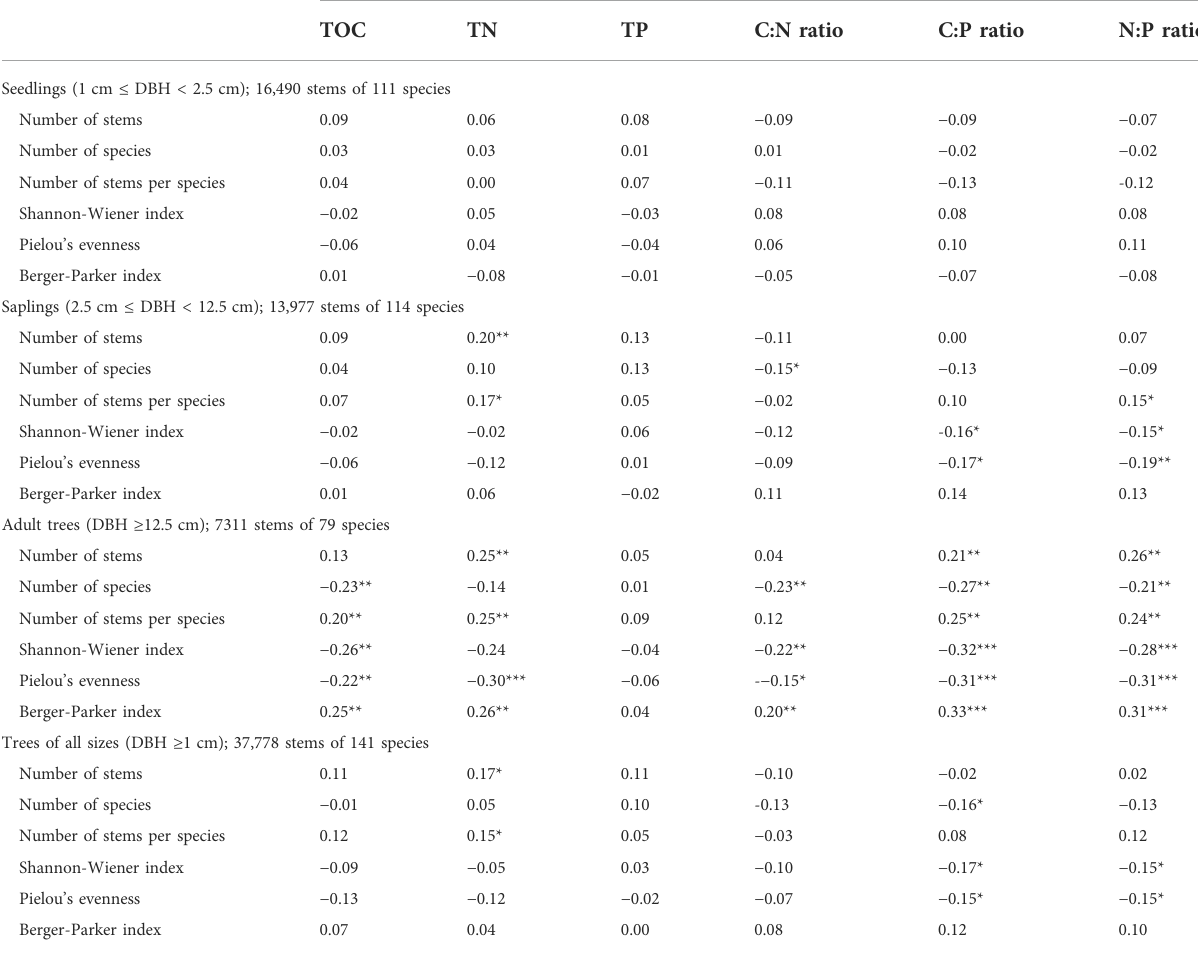
TABLE 2 Pearson correlation coef fi cients of six vegetation-related biotic factors with soil total organic carbon (TOC, g kg − 1 ), total nitrogen (TN, g kg − 1 ), total phosphorus (TP, g kg − 1 ), and C:N:P stoichiometric ratios at the quadrat level. Asterisks (*, **, or ***) alongside a coef fi cient indicate statistical signi fi cance at p < 0.05, < 0.001, or < 0.0001,